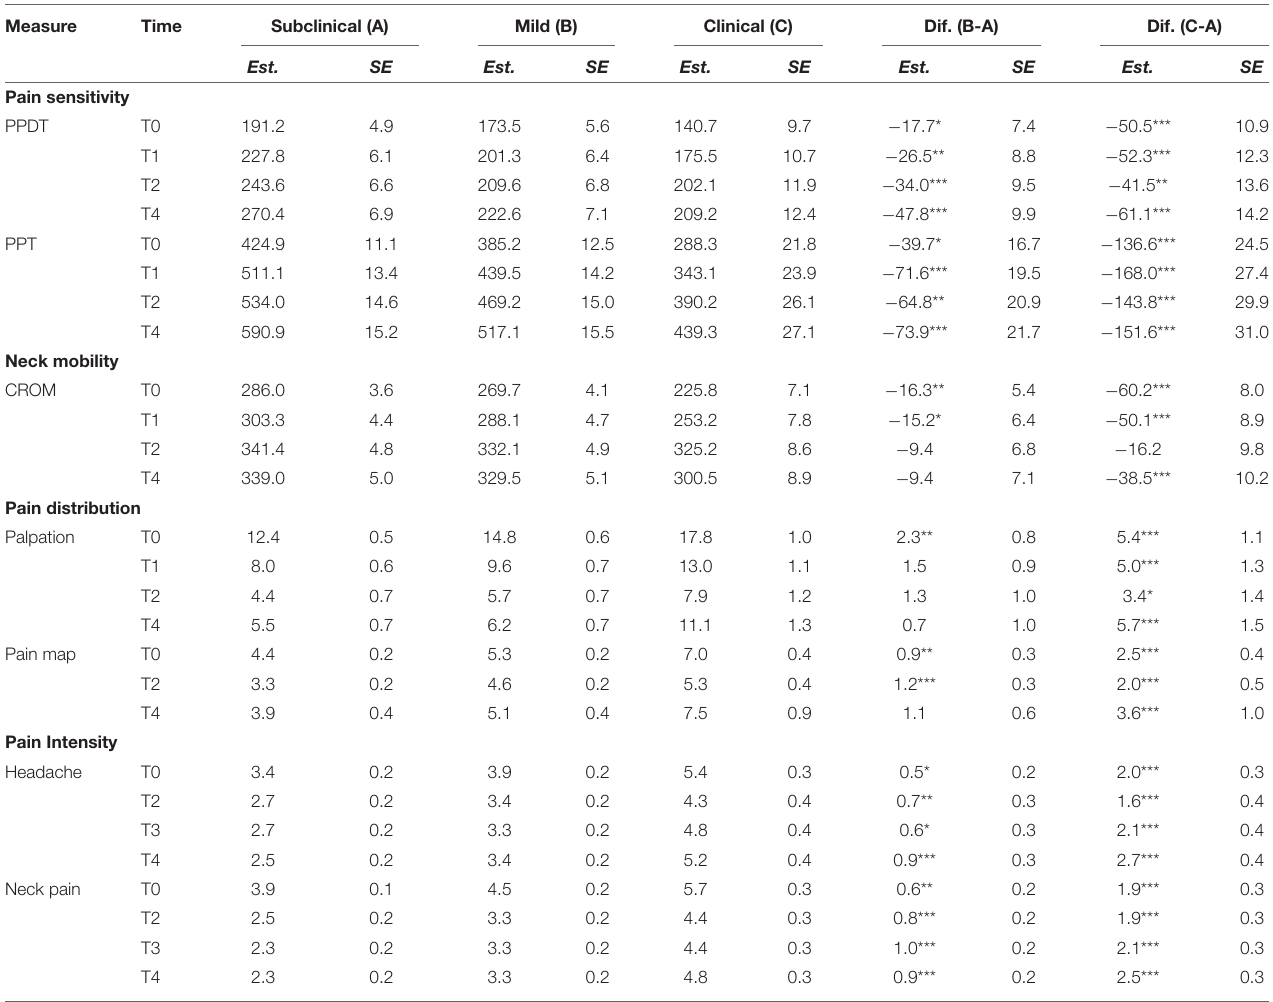
TABLE 3 | Differences in outcomes for the three PTSS groups at each time point. Measure Time Subclinical (A) Mild (B) Clinical (C) Dif. (B-A) Dif. (C-A) Est. SE Est. SE Est. SE Est. Est.